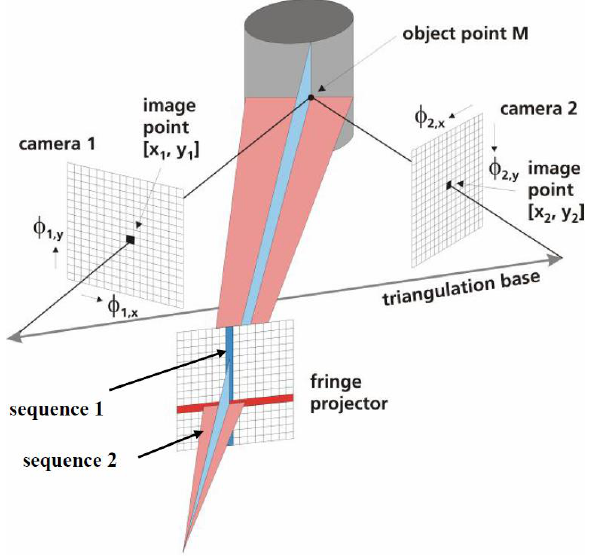
Figure 7. Principle of phase correlation using fringe projection Typically, a four-, six-, or eight-phase-shift algorithm (see Creath 1986) in addition to a Gray-code sequence is used for phase generation. Hence, one projected image sequence